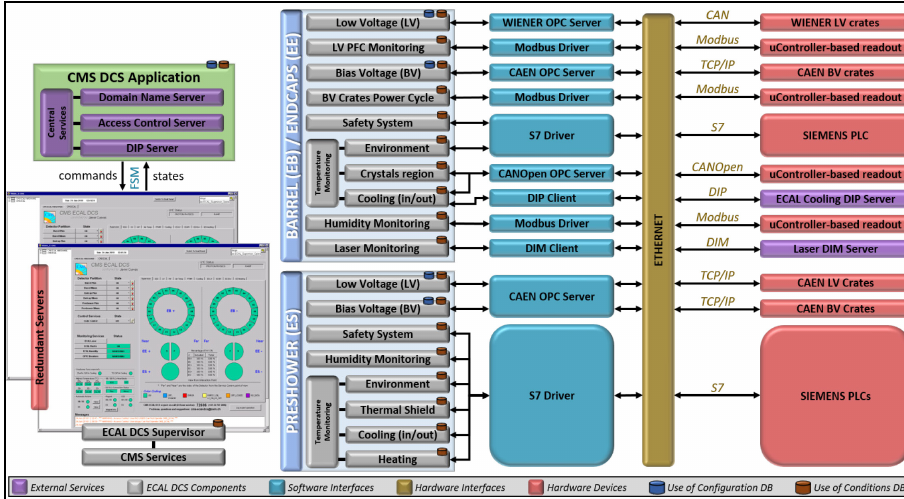
Figure 2. The CMS ECAL DCS